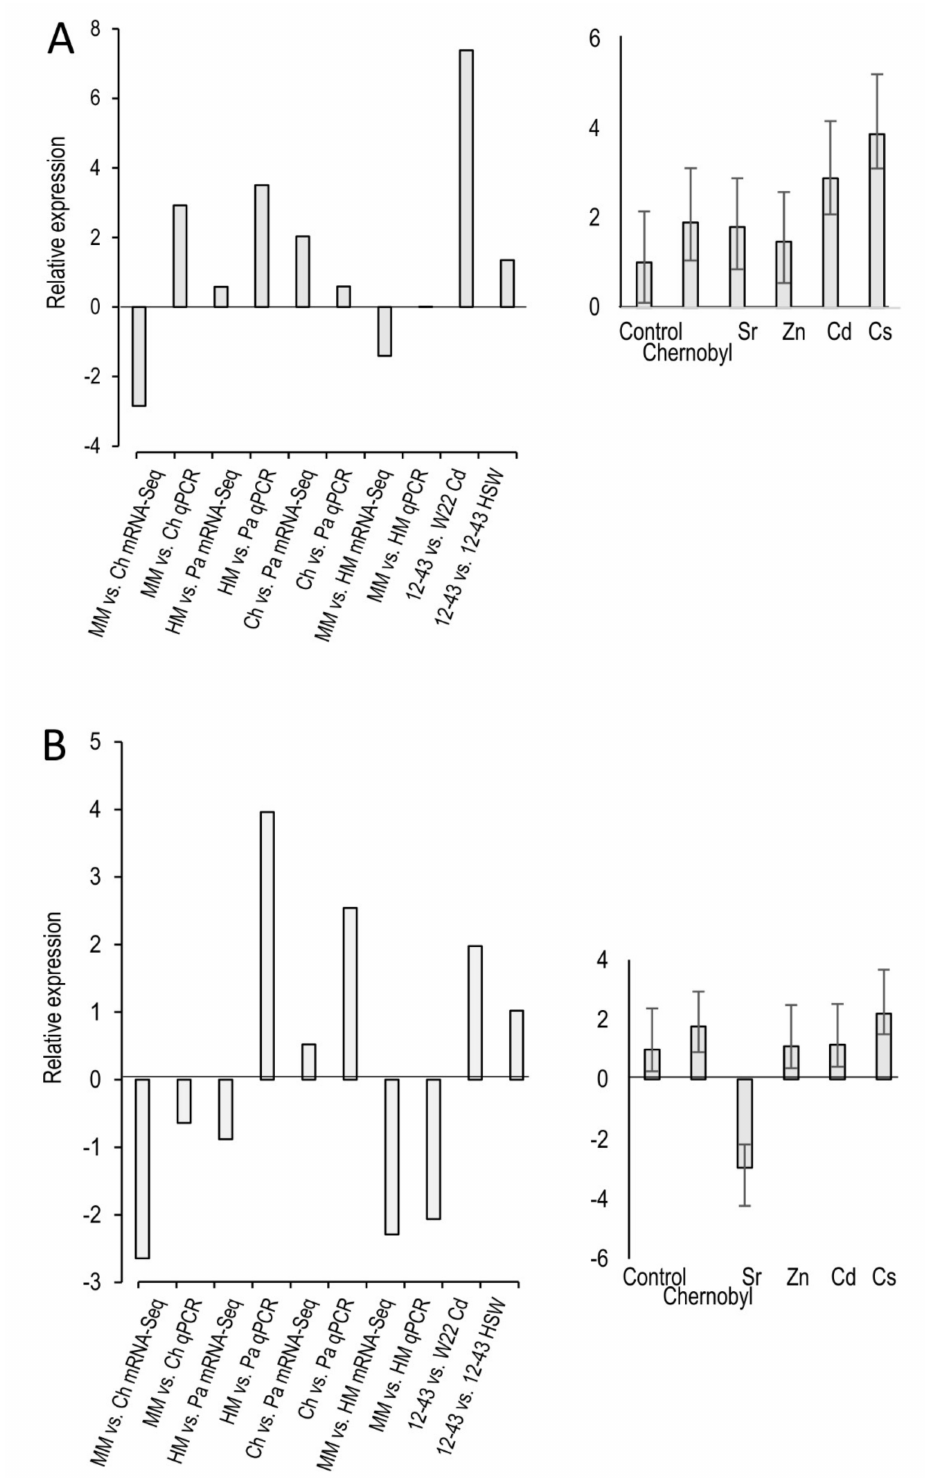
Figure 4. Validation of mRNA sequencing by microarray and qPCR (left) and further investigation by qPCR (right) for inositol polyphosphate phosphatase ( A ) and myo-inositol monooxygenase ( B ). S. commune 12-43 or S. commune W22 were grown on minimal medium (MM), minimal medium containing the heavy metals present in Paradies park soil (HM), directly in Chernobyl soil (Ch), Paradies park soil (PA) or seepage water